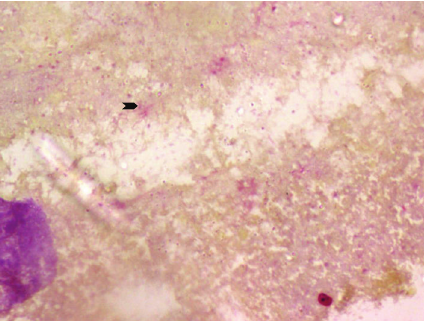
Figure 4: Gram negative bacilli in the abscess (arrow head) (Gram stain, ×